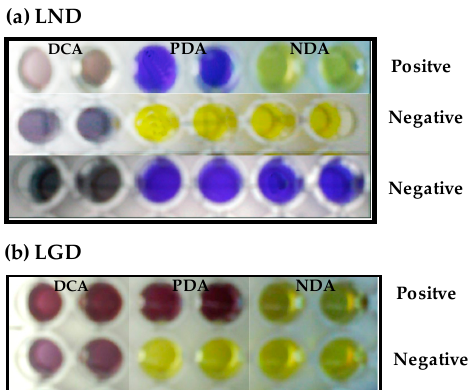
Figure 1. Example of negative and positive responses to amino acid decarboxylase activity in Low Nitrogen Decarboxylase (LND) and Low Glucose Decarboxylase (LGD) media. DCA: decarboxylase control assay; PDA: positive decarboxylase assay; NDA: negative decarboxylase assay.